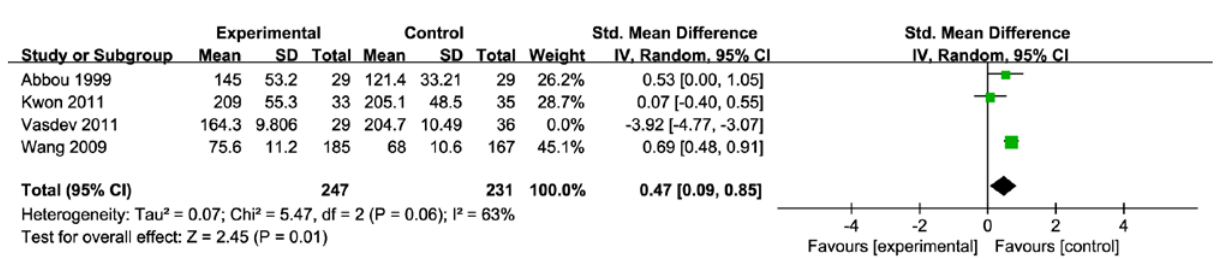
Figure 1: The study selection process